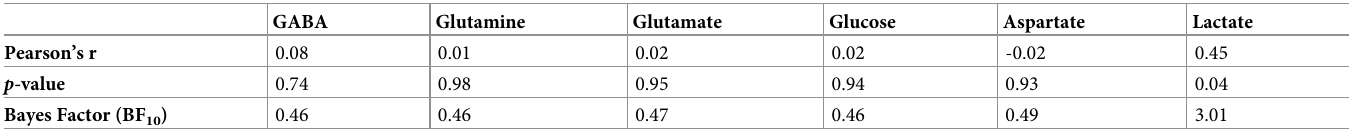
Table 2. Pearson’s correlation and Bayes factors for the correlations between the change in MRS-measured metabolites with the change in EEG response amplitude